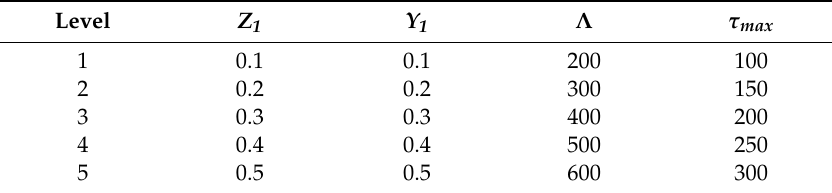
Figure A4. The main effect graph of GA. Table A7. GA parameters level.